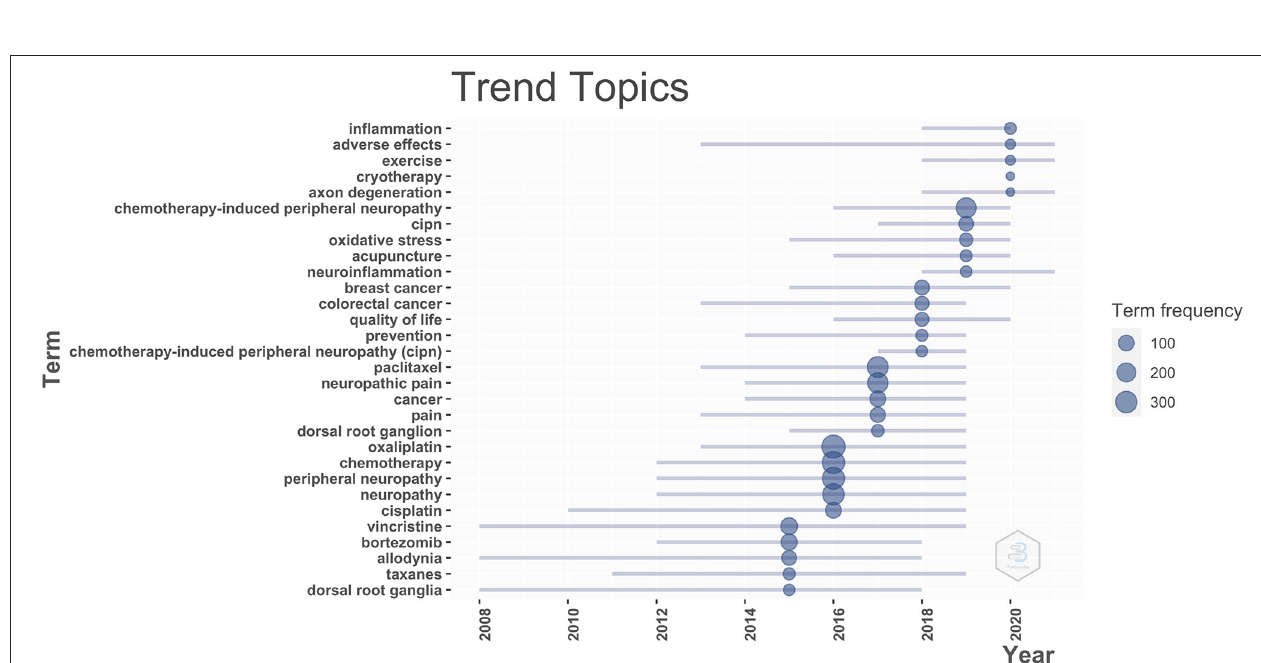
FIGURE 4 | Visualization of keywords related to CIPN research between 2000 and 2021.